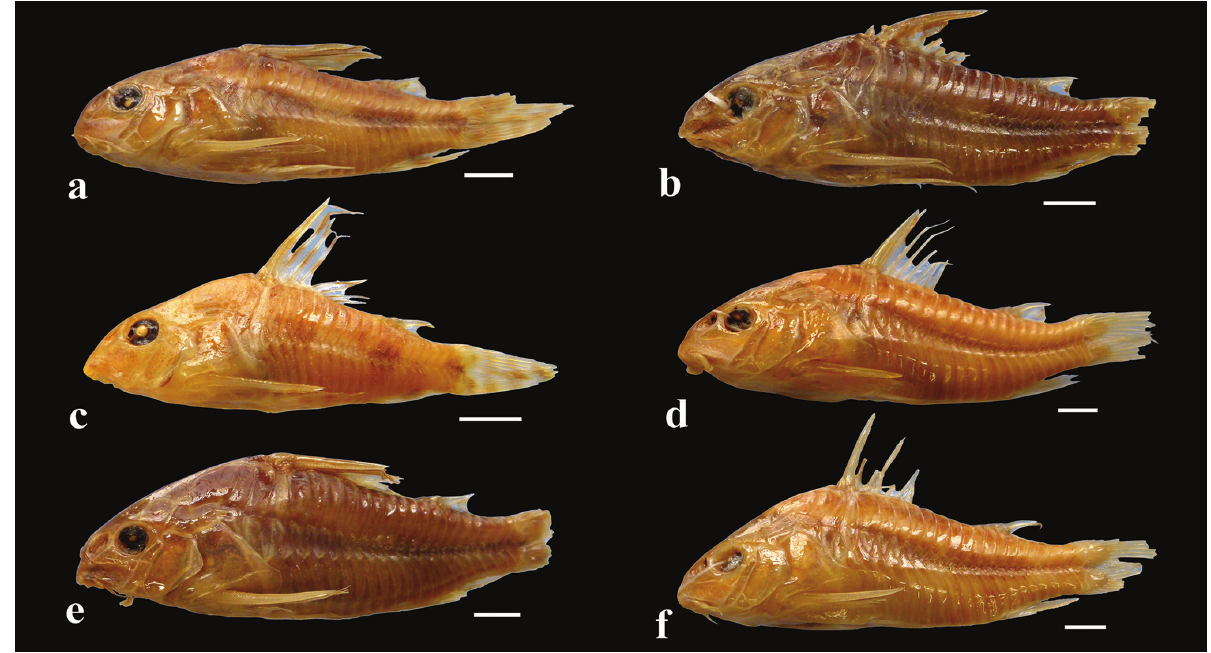
Fig. 7. Type-specimens of Corydoras marmoratus , showing (a) the lectotype, NMW 5538, and the paralectotypes (b) NMW 46775-2, (c) NMW 46776, (d) NMW 46777-1, (e) NMW 46775-1, and (f) NMW 46777-2. Scale bar = 5.0 mm. Photos by Helmut